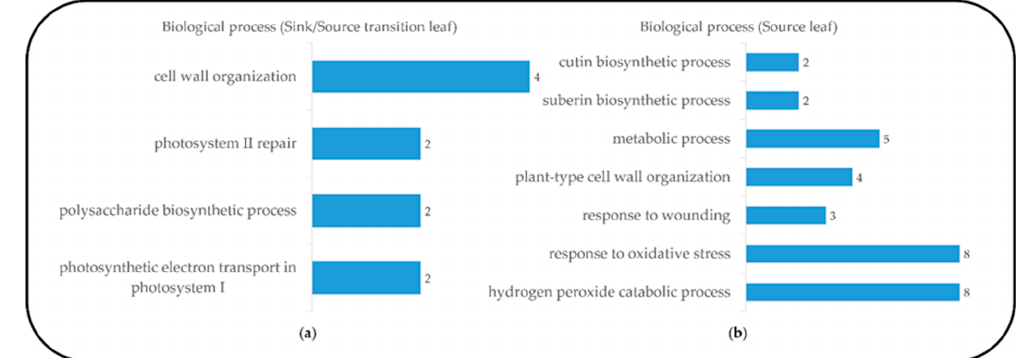
Figure 3. Functional category distribution of selected upregulated genes assigned by gene ontology (GO) terms to biological processes during sink-to-source transition and source stage in the blade tissue, from the database for annotation, visualization and integrated discovery (DAVID, v 6.8), sink-to-source stage ( a ) and source stage ( b ). 2.2. Validation of RNA-seq Data by qRT-PCR Analysis To validate the RNA-seq data using real-time qRT-PCR, cell wall organization-related genes from groups of 153 (sink-to-source) and 229 (source) DEGs were selected. On the basis of GO analysis, we divided these genes into two categories, primary (sink-to-source transition) and secondary cell wall organization (source stage) related genes. The expression patterns of the selected cell wall development-related genes, namely, glycosyltransferase (GT 43), endotransglucosylase/hydrolase (XTH), Endoglucanase 16, cellulose-synthase- like C (CslC), glycosyltransferase (GT 8), fatty acyl reductase (FAR), ATP-binding cassette (ABC) transporter, glycerol-3-P acyltransferase (GPAT 3) and BAHD acyltransferase and peroxidase (POD), were positively correlated with the results of qRT-PCR (Tables 1 and 2). Table 1. Expression of primary cell wall organization-related genes by RNA-seq and qRT-PCR (mean ± S.D.). GO Term Gene